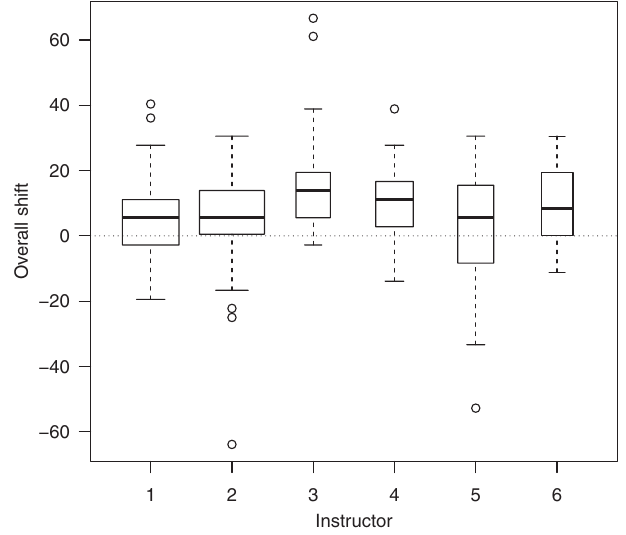
FIG. 3. Box plot of the shift in overall percent favorable responses for each of the instructors in the new data set. The box width is scaled by the square root of n for each instructor. In each box, the thick center line indicates median shift, and the lower and upper bounds represent the first and third quartiles, respectively. The whiskers show the extent of the remaining data out to 1 : 5 (cid:3) the box size; points outside this range are marked as circles, and represent students with very large shifts.